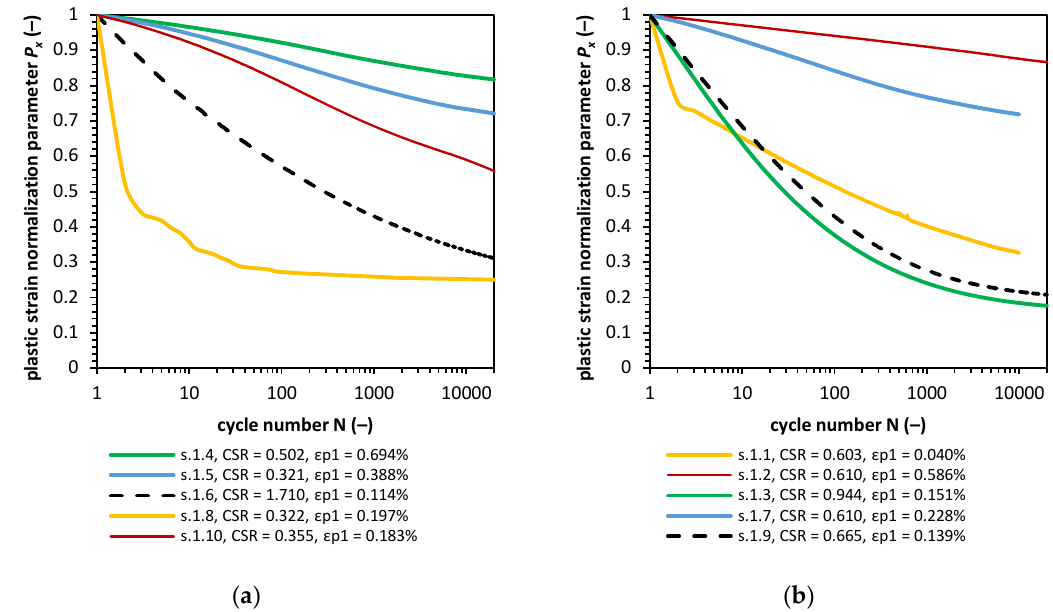
Figure 8. Plastic strain normalization parameter in confining pressure equal to 18, 90 and 135 kPa ( a ), and for the samples consolidated with confining pressure around to 45 kPa ( b ).